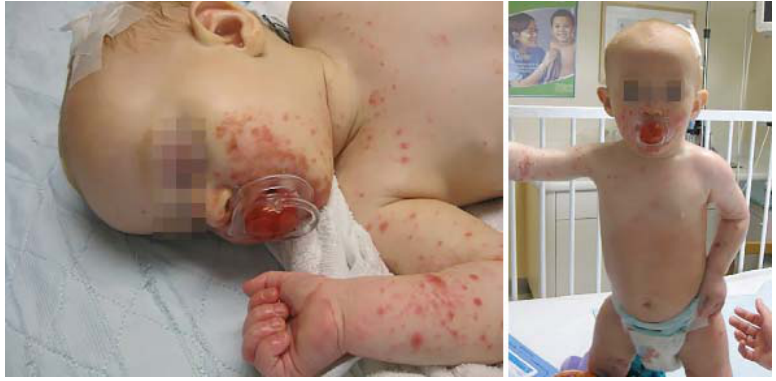
Figure 14 . Eczema coxsackium.